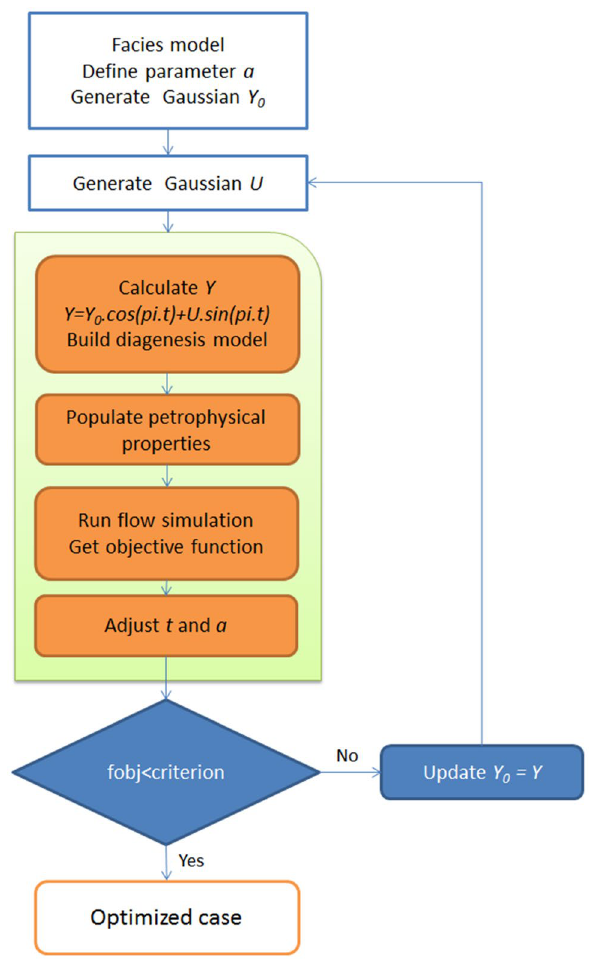
Fig. 14 Flowchart with the steps followed to minimize the objective function